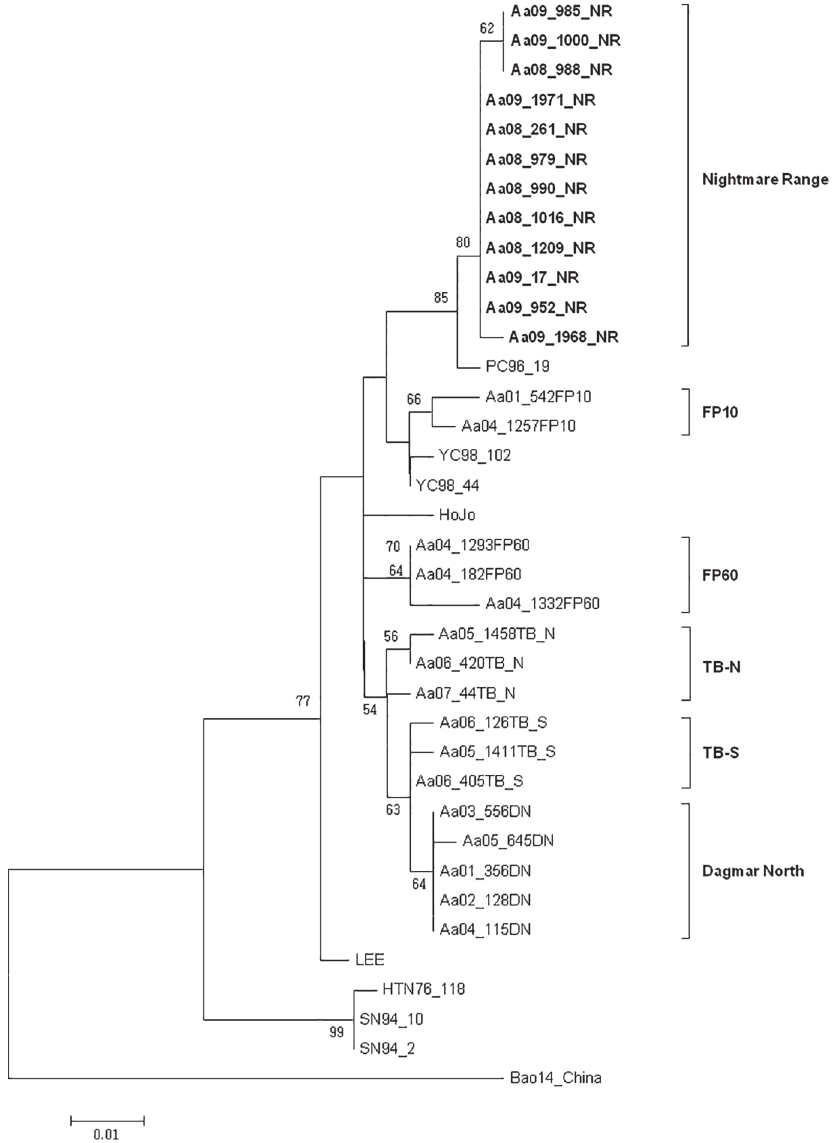
Fig 7. Maximum likelihood method based on a 320-nt region of the G C glycoprotein-encoding M segment of the HTNV amplified from 12 A . agrarius captured at Nightmare Range